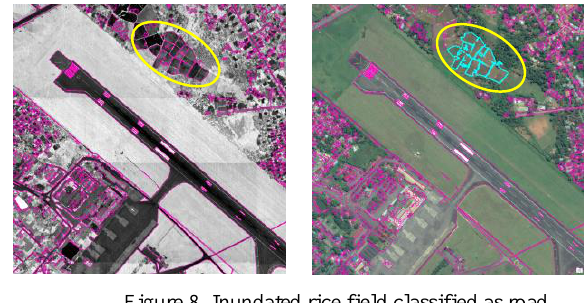
Figure 8. Inundated rice field classified as road (© coloured image by